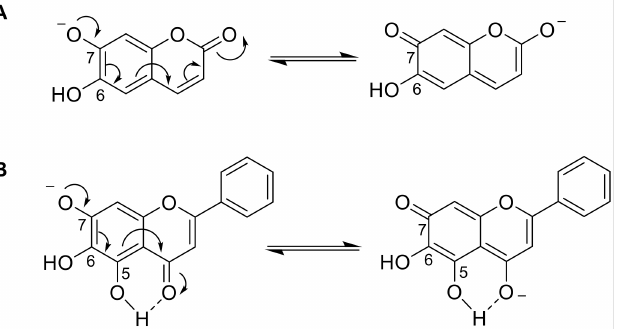
Figure 4. Resonance structures of ( A ) coumarin 6 and ( B ) flavonoid 10 under mild basic